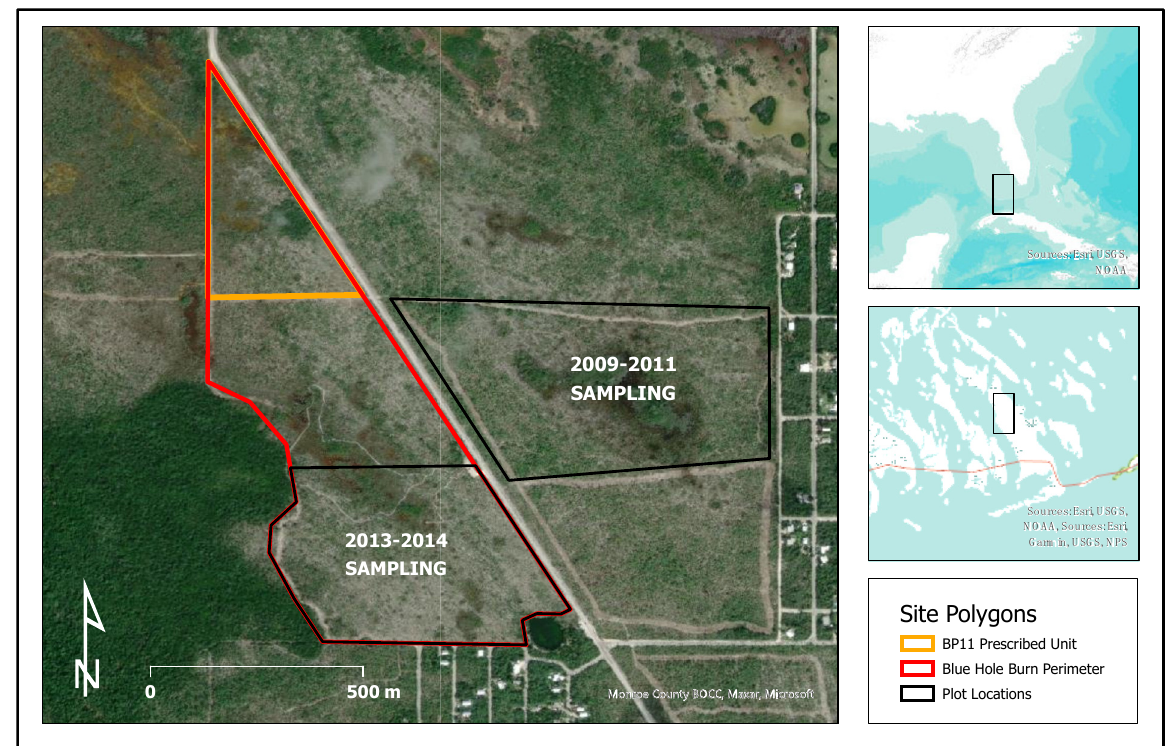
Figure 1. Map of 2011 planned burn unit (BP11; orange polygon), the 2011 Blue Hole Burn perimeter (red polygon), and the locations for plots from Harley et al. [26] and the current study (black polygons). Supplementary materials include GPS locations of individual trees in 2013-2014 sampling polygon and the FHX data for the same collection.